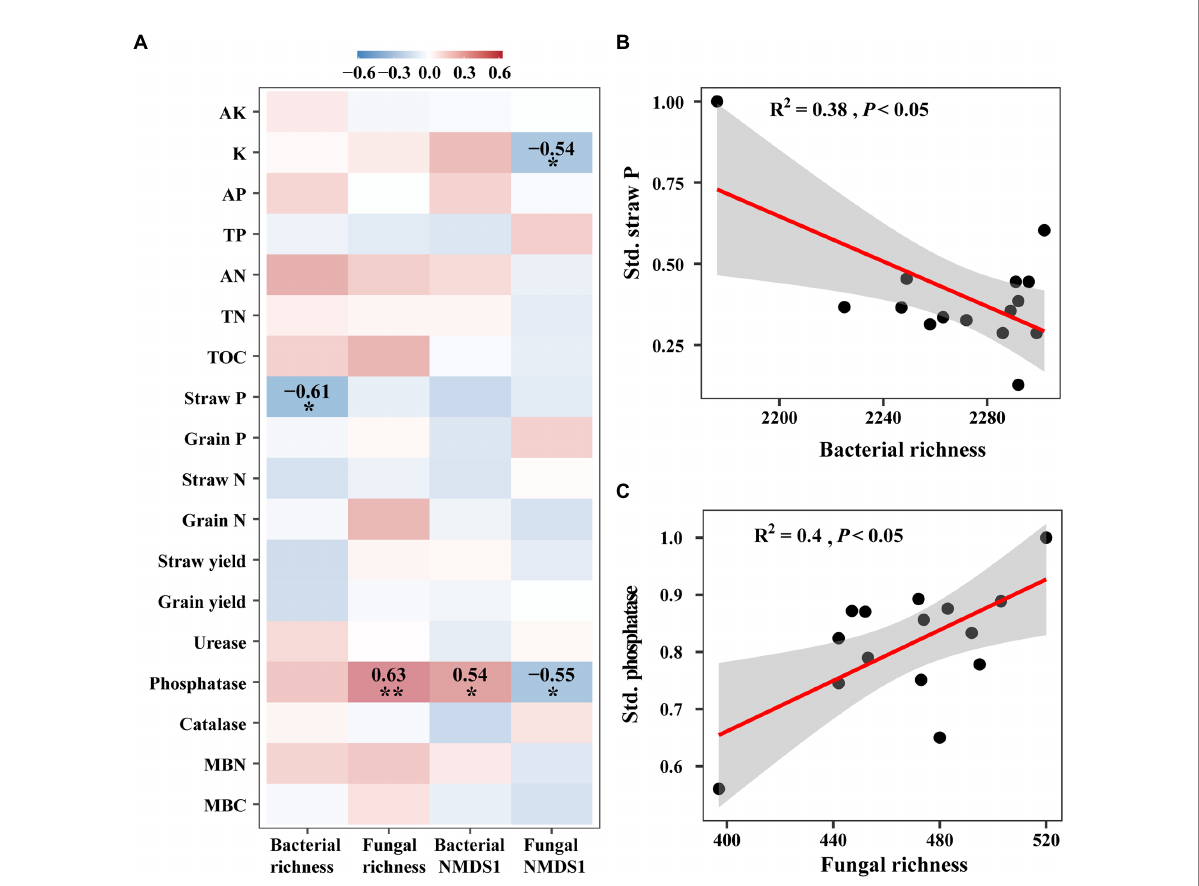
FIGURE 4 The relationships between ecosystem functions and microbial diversity. (A) Heatmap of the Spearman correlations between bacterial and fungal richness and composition with ecosystem functions. These functions include available potassium (AK), potassium (K), available phosphorus (AP), total phosphorus (TP), available nitrogen (AN), total nitrogen (TN), total organic carbon (TOC), straw yield, grain yield, straw phosphorus (P), grain phosphorus, straw nitrogen (N) and grain nitrogen, urease, phosphatase, and catalase, microbial biomass carbon (MBC) and nitrogen (MBN). (B) Regression relationship between straw phosphorus (Straw P) and bacterial richness. (C) Regression relationship between phosphatase and fungal richness. Red and blue colors represent positive and negative correlation, respectively. * p < 0.05; ** p <